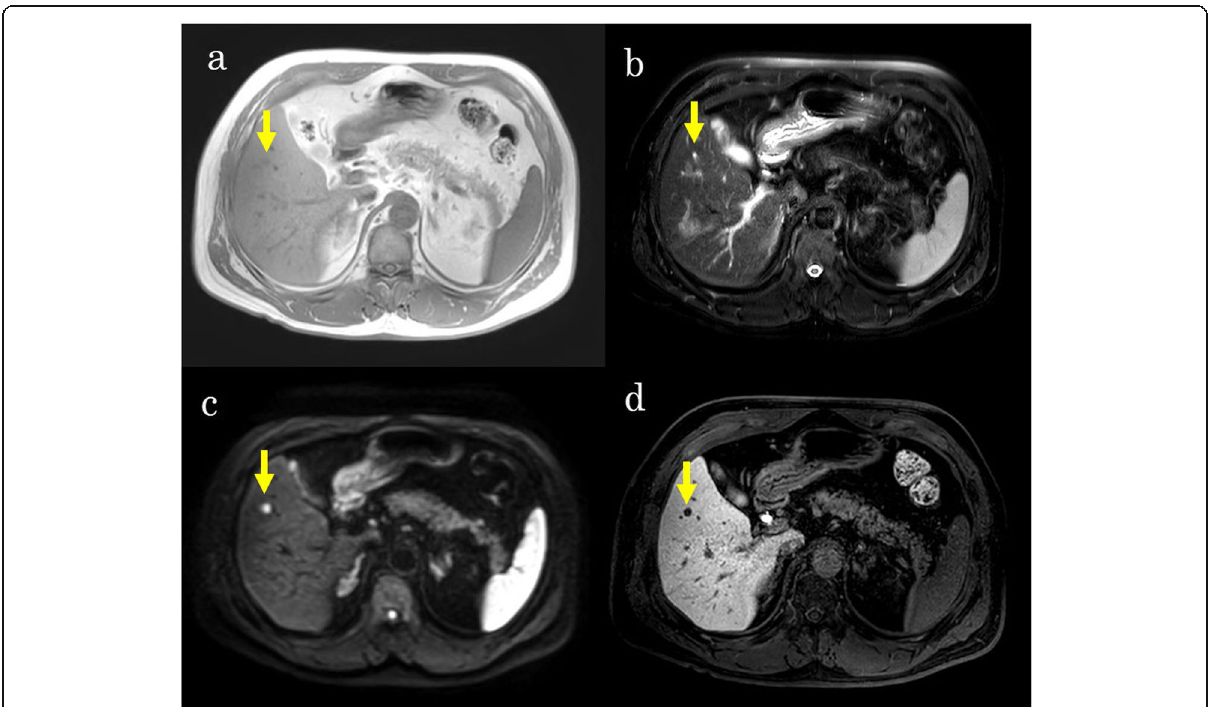
Fig. 2 Magnetic resonance imaging (MRI) 1 year after abdominoperineal resection. a The tumor in segment 6 of the liver (arrow) showed low intensity on T1-weighted images. b The tumor in segment 6 of the liver (arrow) showed high intensity on T2-weighted images. c The tumor in segment 6 of the liver (arrow) showed high intensity on diffusion-weighted images. d The tumor in segment 6 of the liver (arrow) showed low signal intensity on gadolinium-ethoxybenzyl-diethylenetriamine pentaacetic acid-enhanced MRI (EOB-MRI)